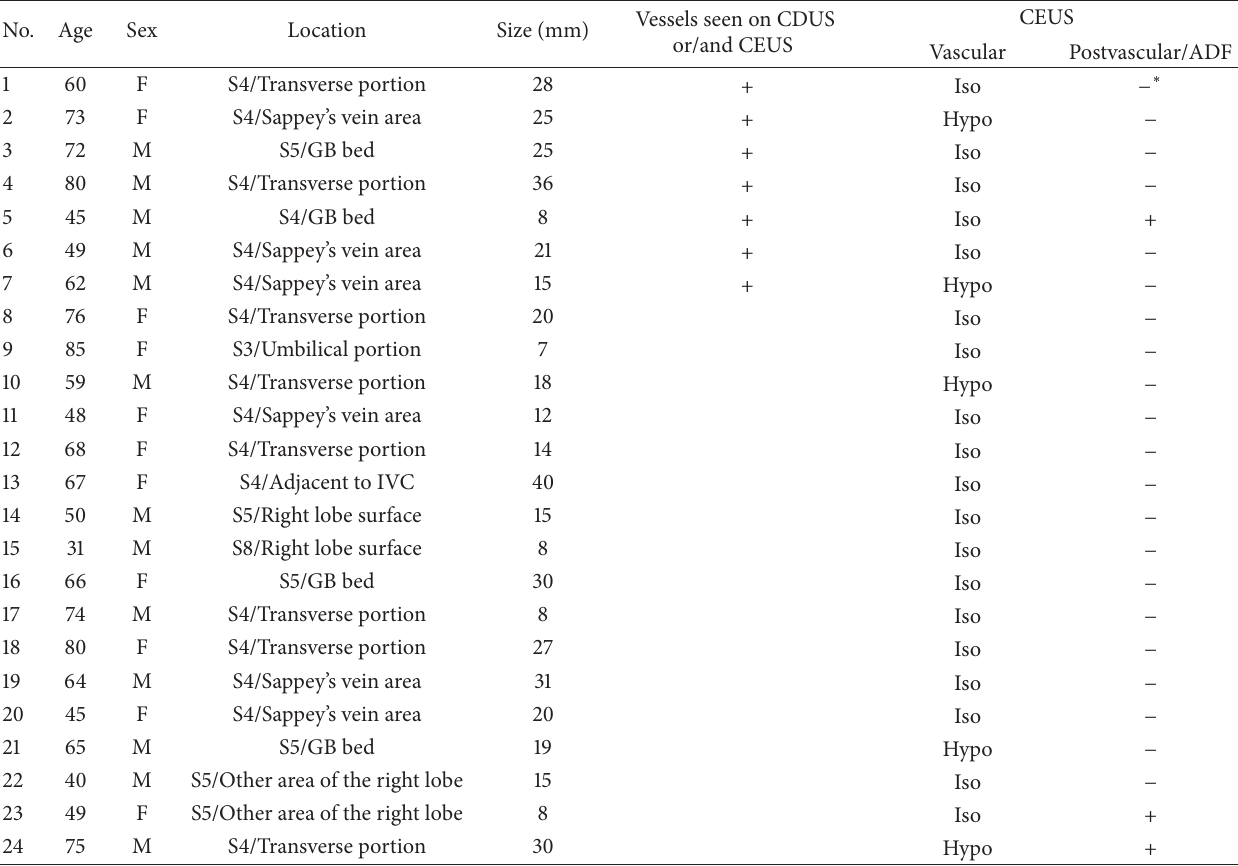
Table 1: Of the 24 lesions with focal steatosis, patients character, location, size, enhancement pattern in the vascular phase of CEUS, presence of existing blood vessel in the CDUS and/or the vascular phase, presence of hypoechoic area in the postvascular phase, and ADF mode of